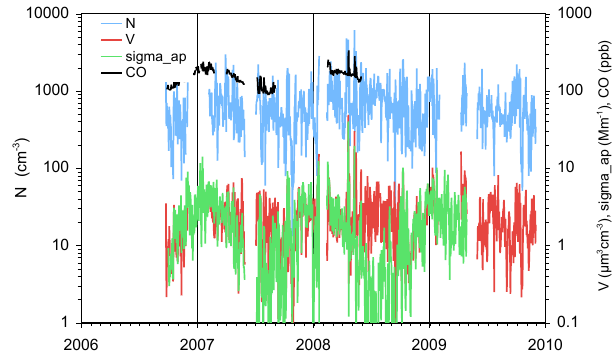
Fig. 1. Daily averages of total number ( N , cm − 3 ), total volume ( V , µm 3 cm − 3 ), particulate absorption at 570nm wavelength ( σ ap , Mm − 1 (average of the 50m and 300m) levels), and carbon monox- ide (CO, ppb) at 300m at ZOTTO,